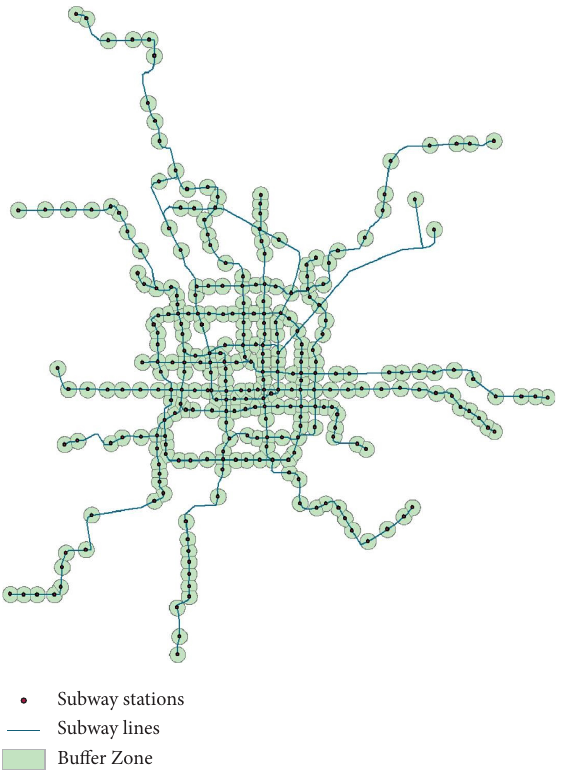
Figure 10: Beijing subway station 800m radius impact area.